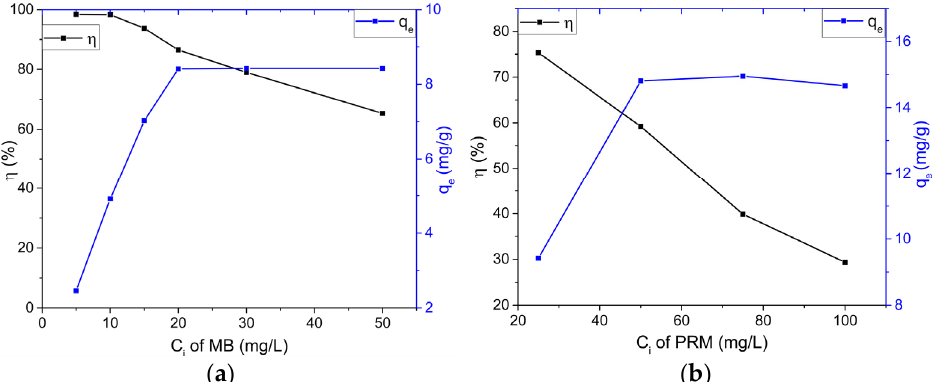
Figure 5. Effect of the initial pollutant concentration on the removal efficiency and maximum adsorbed amount by HCWS3; MB ( a ) and PRM ( b ). The black and blue lines represent the removal efficiency ( η ) and the adsorption capacity ( q e ), respectively.